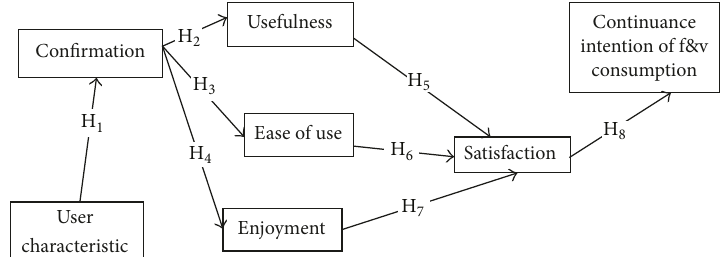
Figure 1: Basic theoretical model of ECM for continuance intention of consuming F&V among the